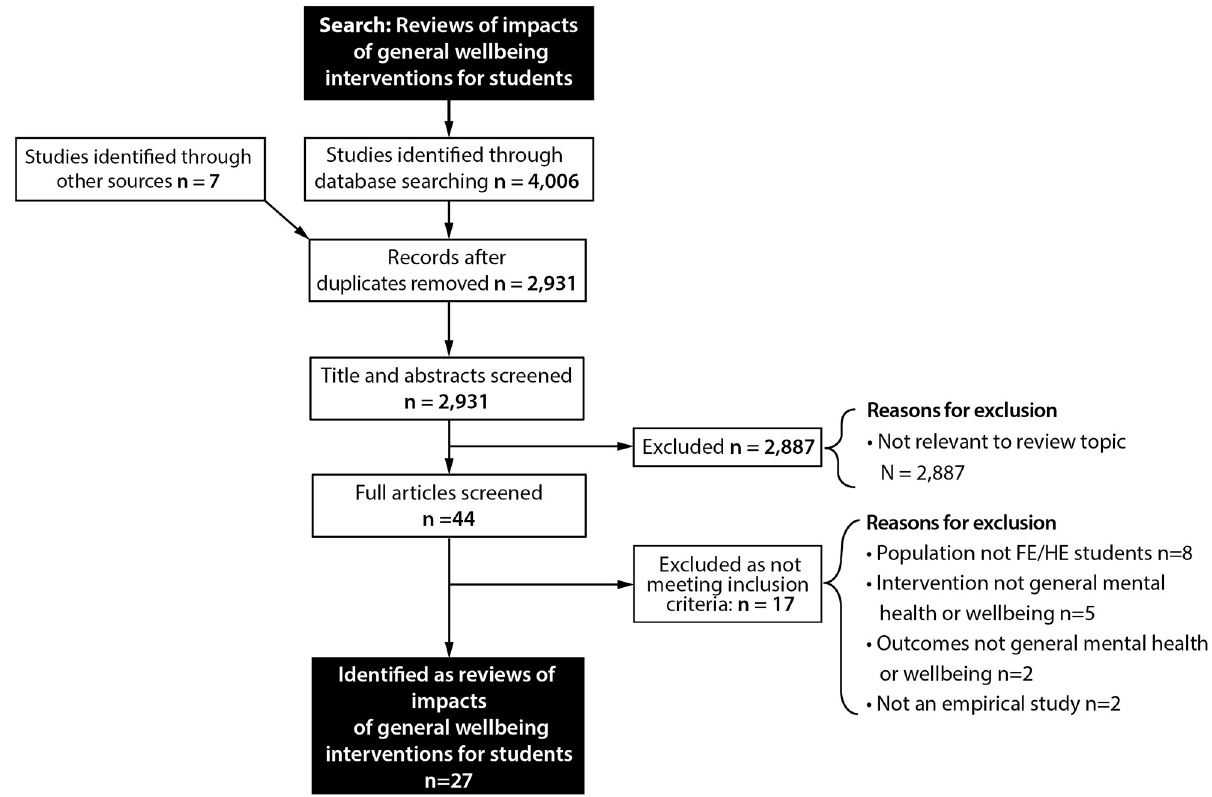
Fig 1. PRISMA flow chart of the progression of studies through the